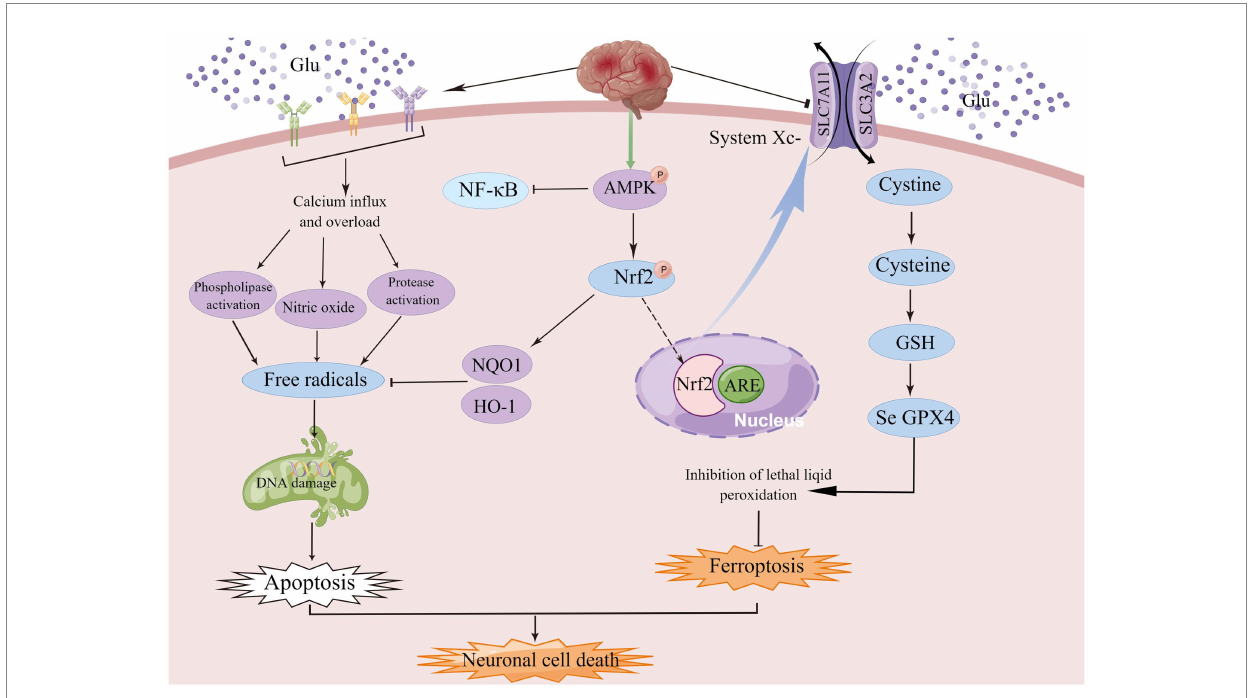
FIGURE 5 AMPK, a member of the serine/threonine kinase family, is an important endogenous defense factor against ischemia, and the Nrf2/ARE signaling pathway counteracts ischemia–reperfusion injury by inducing endogenous antioxidant defense factors and attenuating ROS production during reperfusion